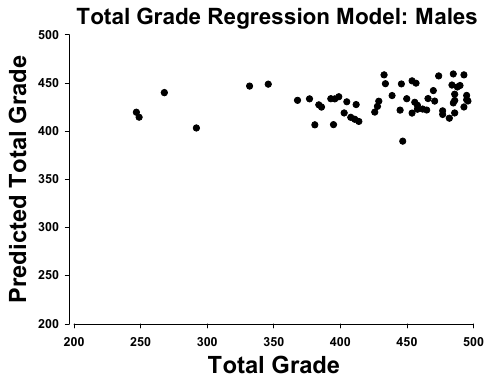
Figure 4. Actual total grade scores in males vs. the predicted value from a regression model including only soda pop hand test times. No additional variables were able to improve the model in males.